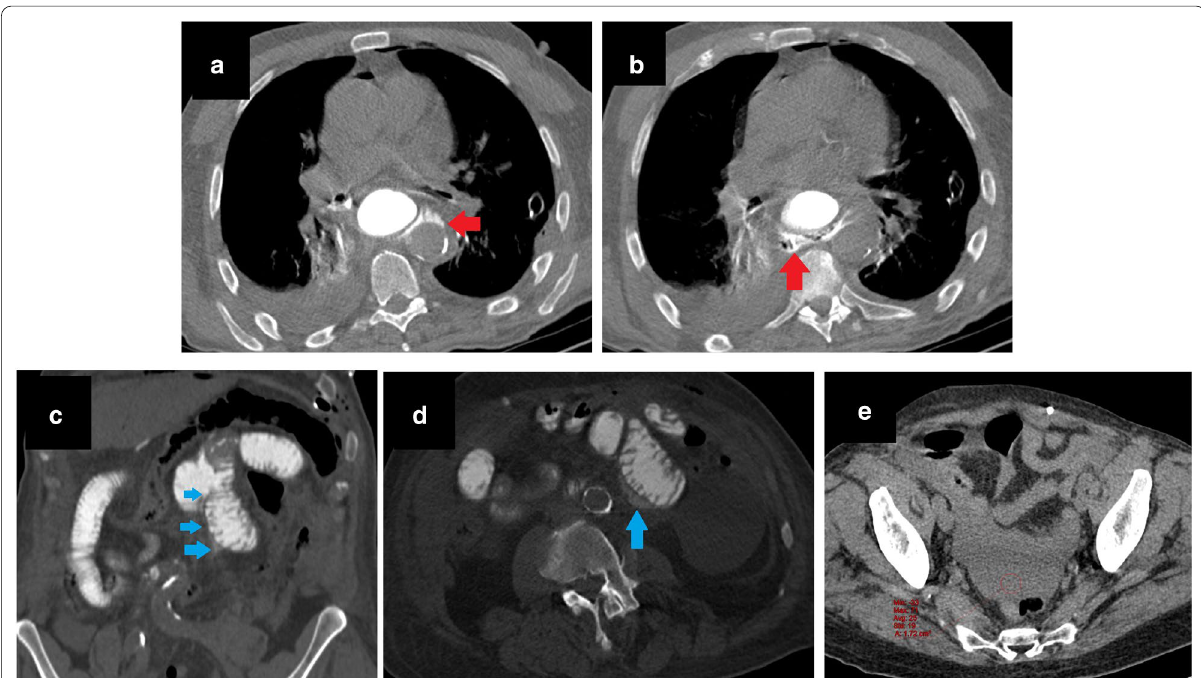
Fig. 13 Satisfaction of search (type 10) error. A patient with gastric cardia tumor underwent total gastrectomy and distal esophagectomy. On the first postoperative day, dyspnea and abdominal pain developed. Anastomosis leakage was suspected, and thoracoabdominal CT with oral contrast agent was performed. The on-call radiologist noticed apparent contrast extravasation from esophagojejunostomy to the posterior mediastinum. The study was reported as “consistent with anastomosis leakage from esophagojejunostomy” (red arrows, a , b ). Due to the “satisfaction of search” effect of this significant finding, the remainder of the examination was reported as normal. However, the patient’s abdominal complaints progressed, and the general condition of the patient deteriorated, so the patient was re-operated on, and additional jejunojejunostomy leakage was detected. When the preoperative CT was retrospectively evaluated, apparent signs of leakage in the jejunojejunostomy area were noticed. Linear hyperdensity consistent with leakage extending inferiorly from the anastomosis (blue arrows, c ), extraluminal contrast material between jejunal loops (blue arrow, d ), and pelvic fluid with relatively high density (red ROI mark, e ) were overlooked